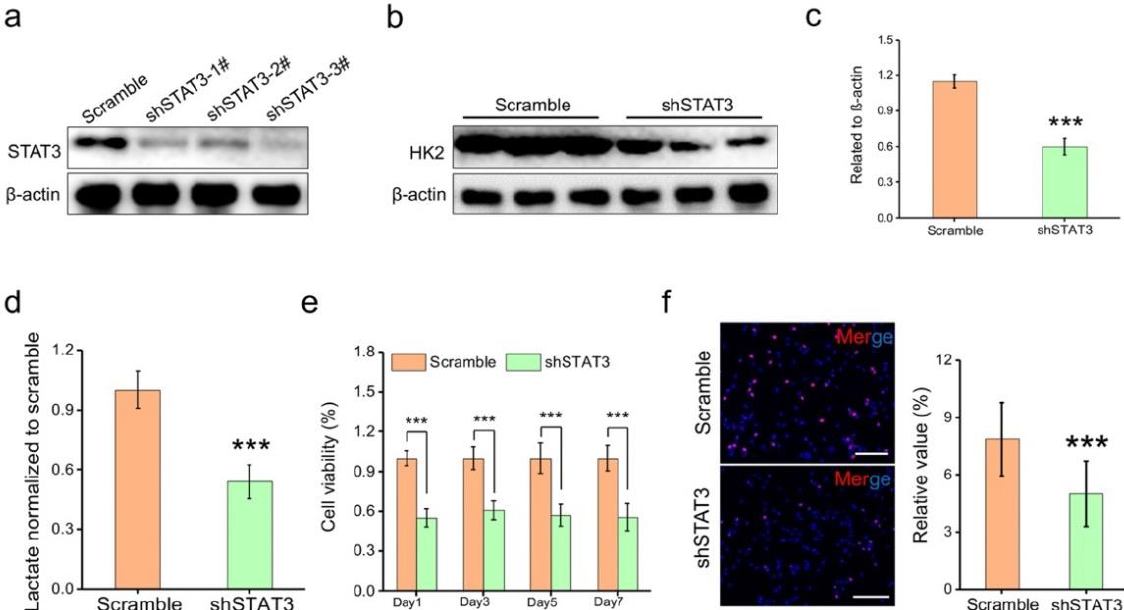
Figure 7. ASP-AMP accelerated HK2-assisted glycolysis via JAK2/STAT3 activation to enhance liver regeneration. ( a ) Efficiency of knockdown of STAT3 in NCTC clone 1469 cells. ( b ) HK2 was analyzed by Western blot in STAT3 knockdown hepatocytes ( n = 3). ( c ) Densitometric analysis of protein ex- pr ession related to β -actin. ( d ) Lactate in supernatant of STAT3 knockdown hepatocytes ( n = 3). ( e )